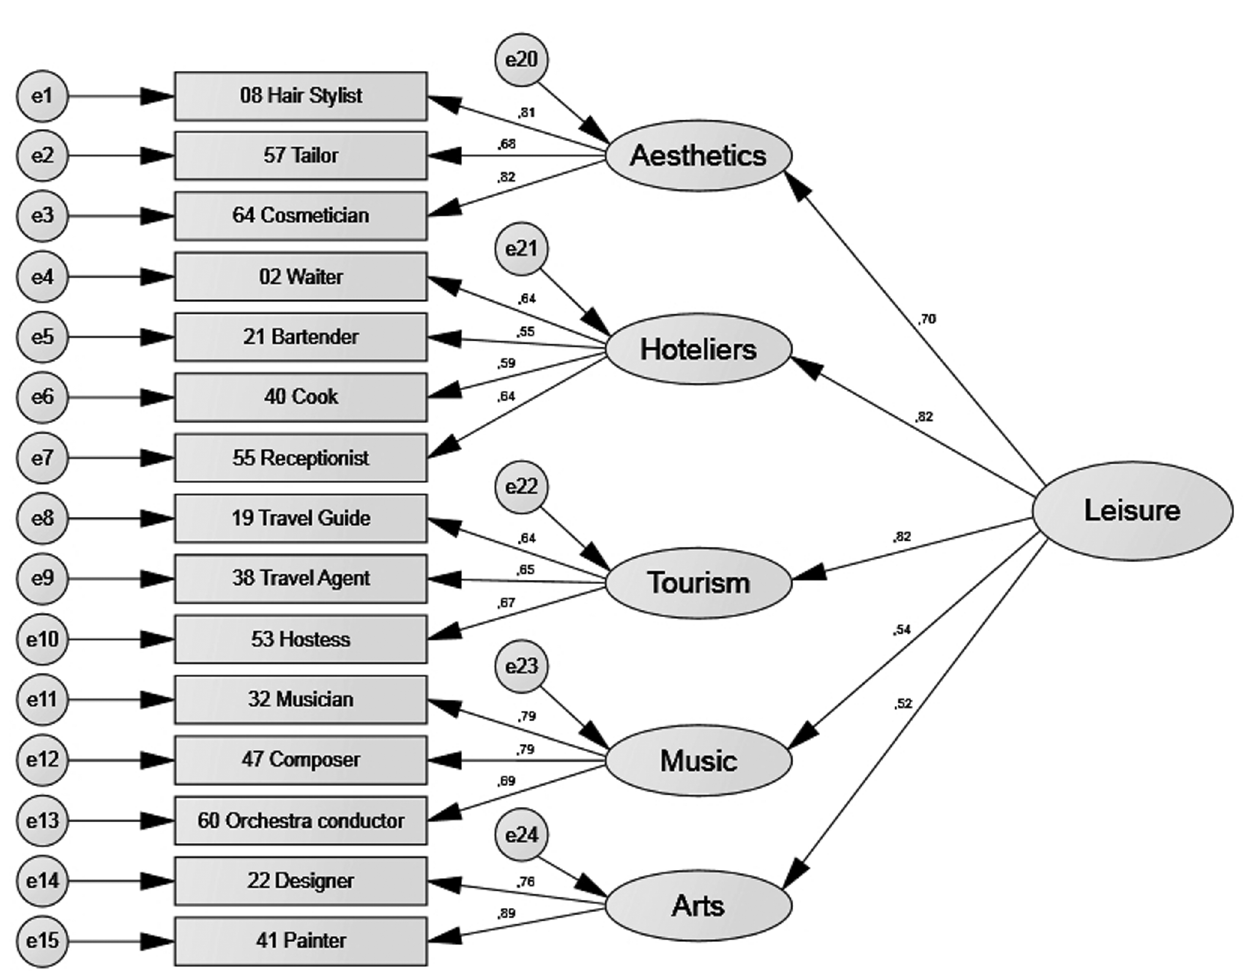
Figure 3. Standardised estimates for the leisure factor.